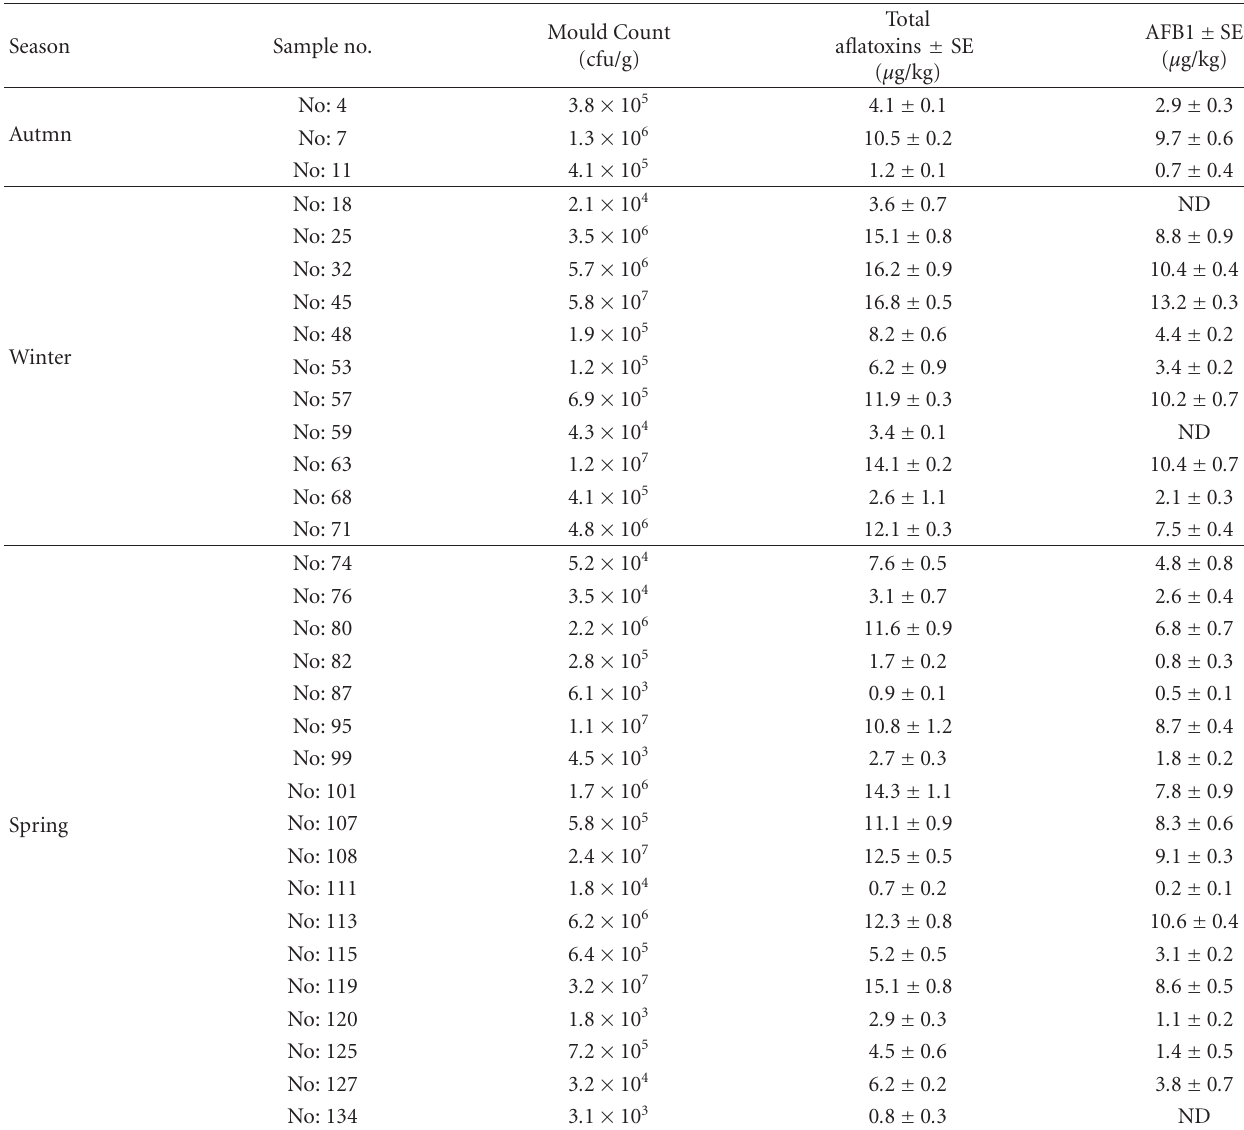
Table 3: Mould counts and Aflatoxin amounts of contaminated tarhana